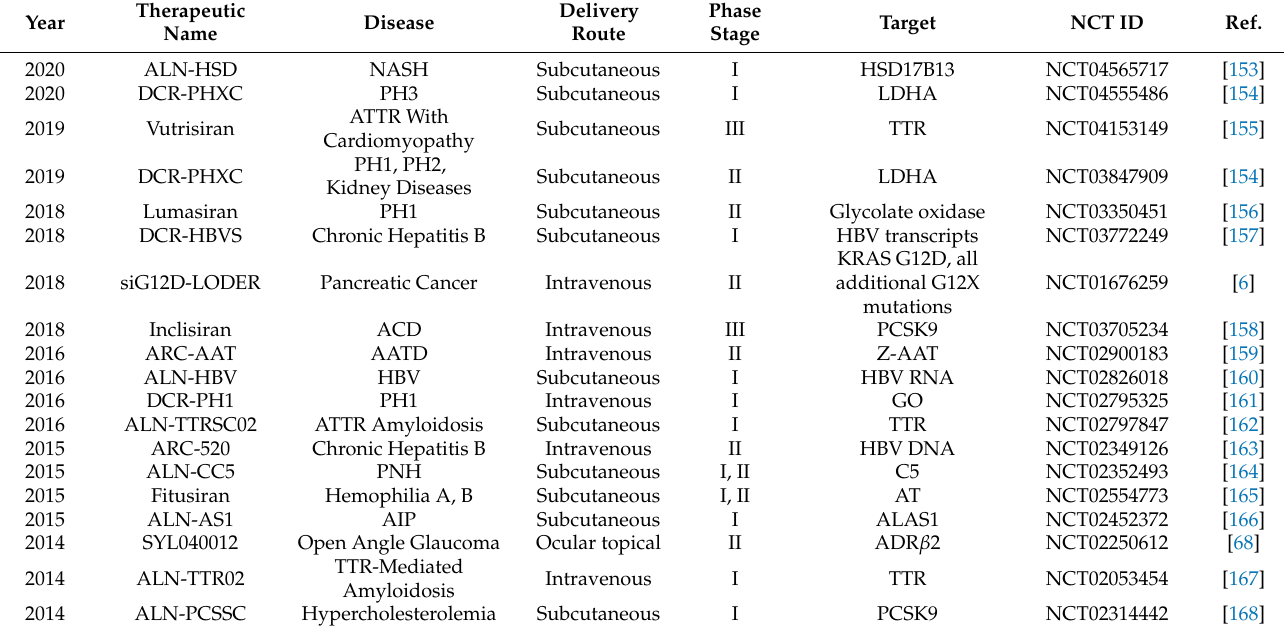
Table 5. Representative clinical trials of RNAi therapeutics in the past 10